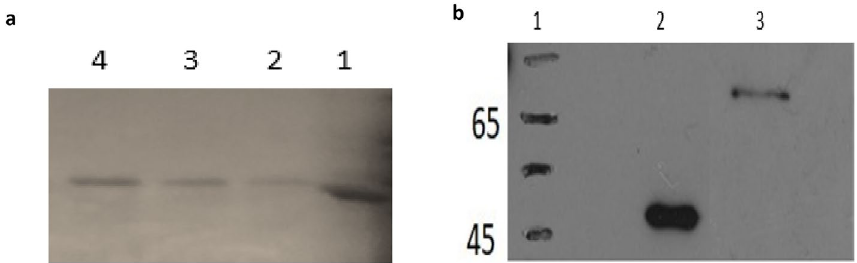
Figure 2. ( a ) Analysis of purified S-TRAIL using Comassie blue stained SDS-PAGE (12.5% polyacrylamide gel). Lane1. Molecular weight marker (62KDa), Lane 2–4. S-TRAIL (MW ~ 66 KDa). ( b ) Western blot analysis of S-layer and S-TRAIL using monoclonal anti-His tag antibody and goat anti-mouse AP conjugated antibody. Lane1. Molecular weight marker, Lane2. S-layer and Lane3. S-TRAIL.